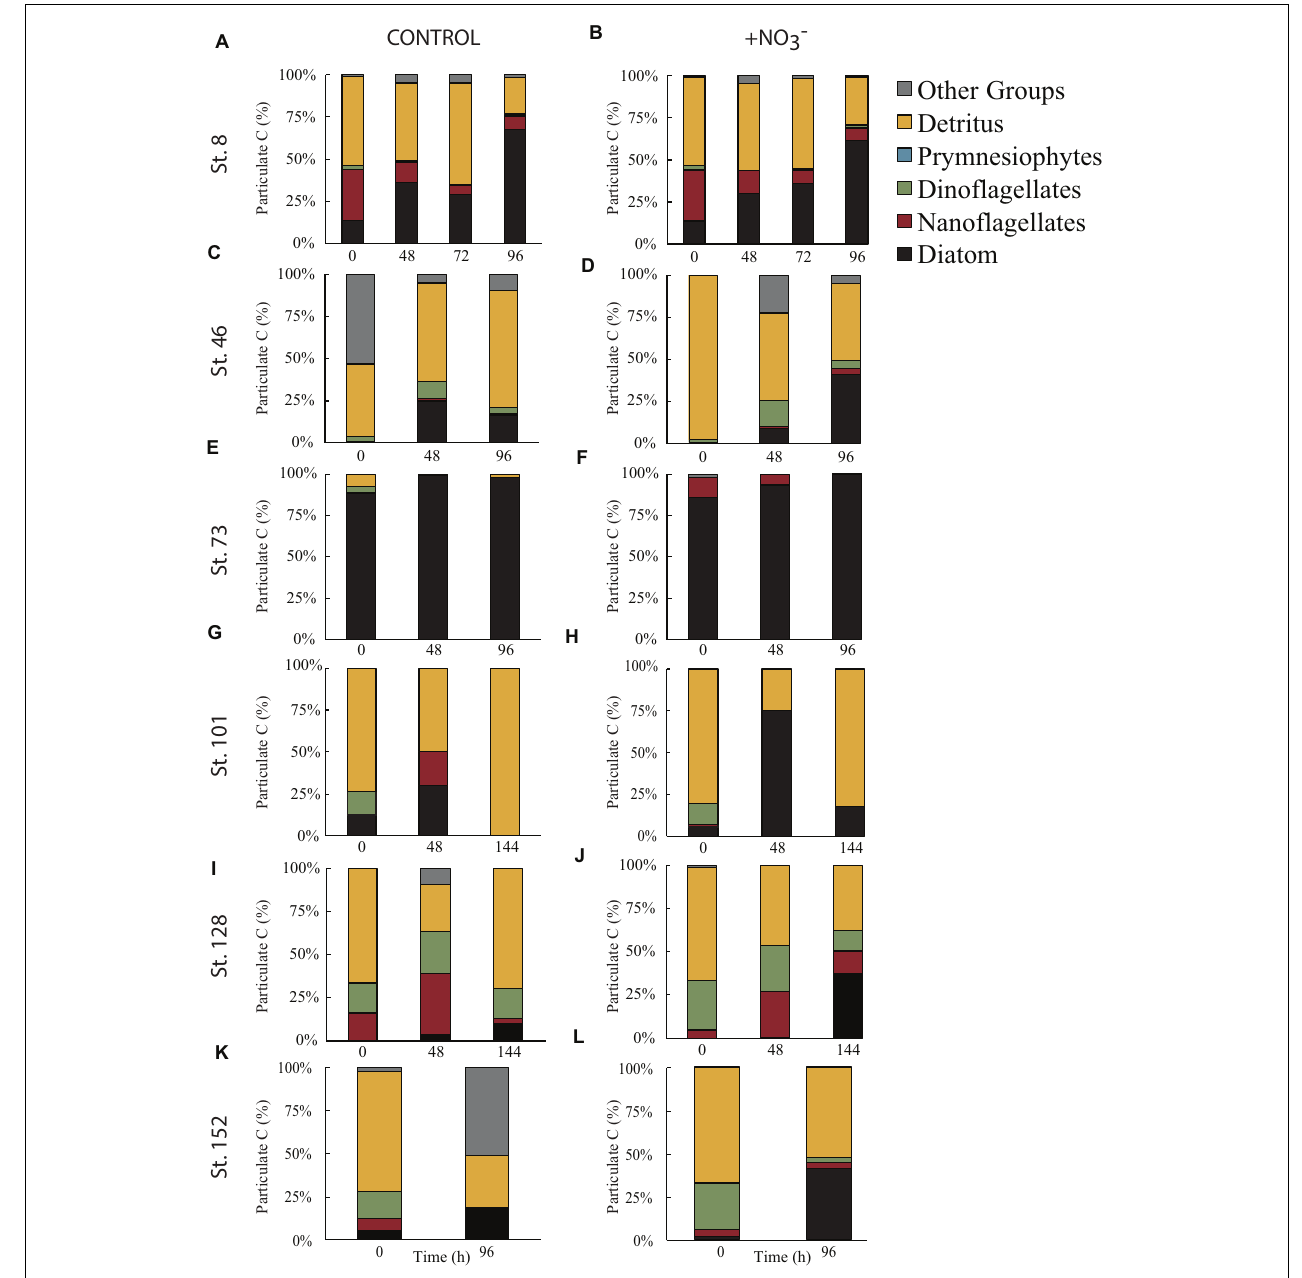
FIGURE 5 | Fraction of particulate C biomass separated into algal taxonomic groups or detritus during the control (A,C,E,G,I,K) and nutrient amended (B,D,F,H,J,L) treatments. Other groups represent phytoplankton that do not fall into one of the listed categories.